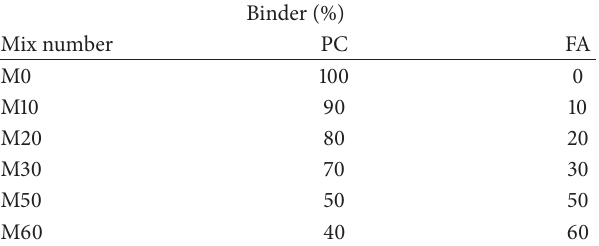
Table 4: Composition of